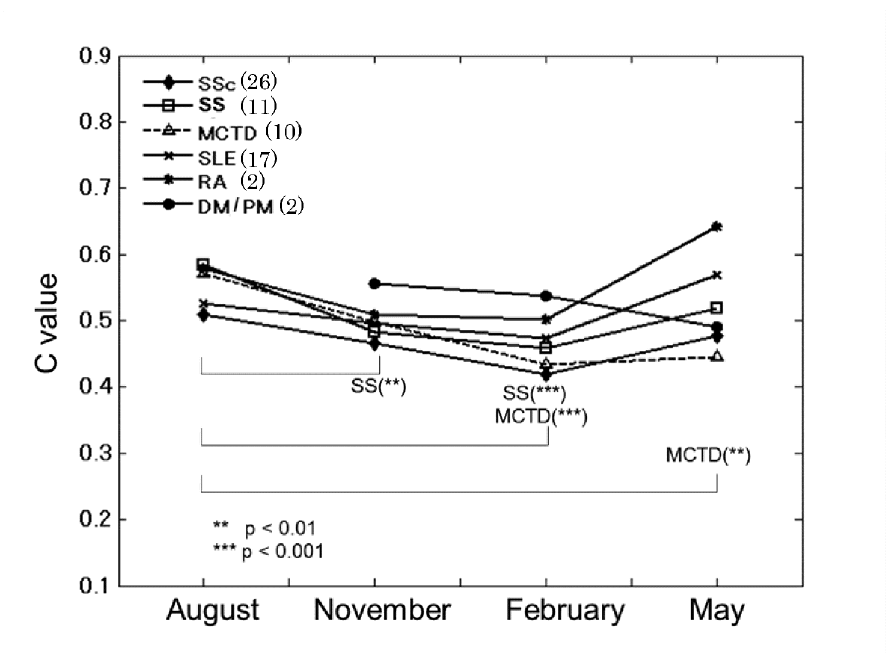
Fig 4. Time course, in each disease, of same-finger C values for images compared with those first acquired data in June. August DM/PM data could not be acquired because of the absence of patients. Mean values are plotted. ** p < 0.01, *** p <